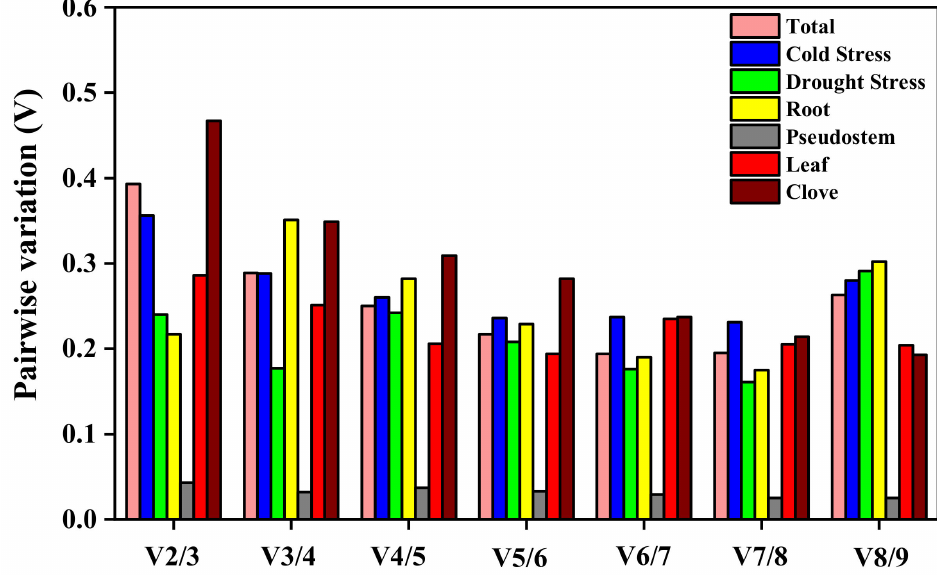
Figure 5. Determination of optimal parameters for candidate reference